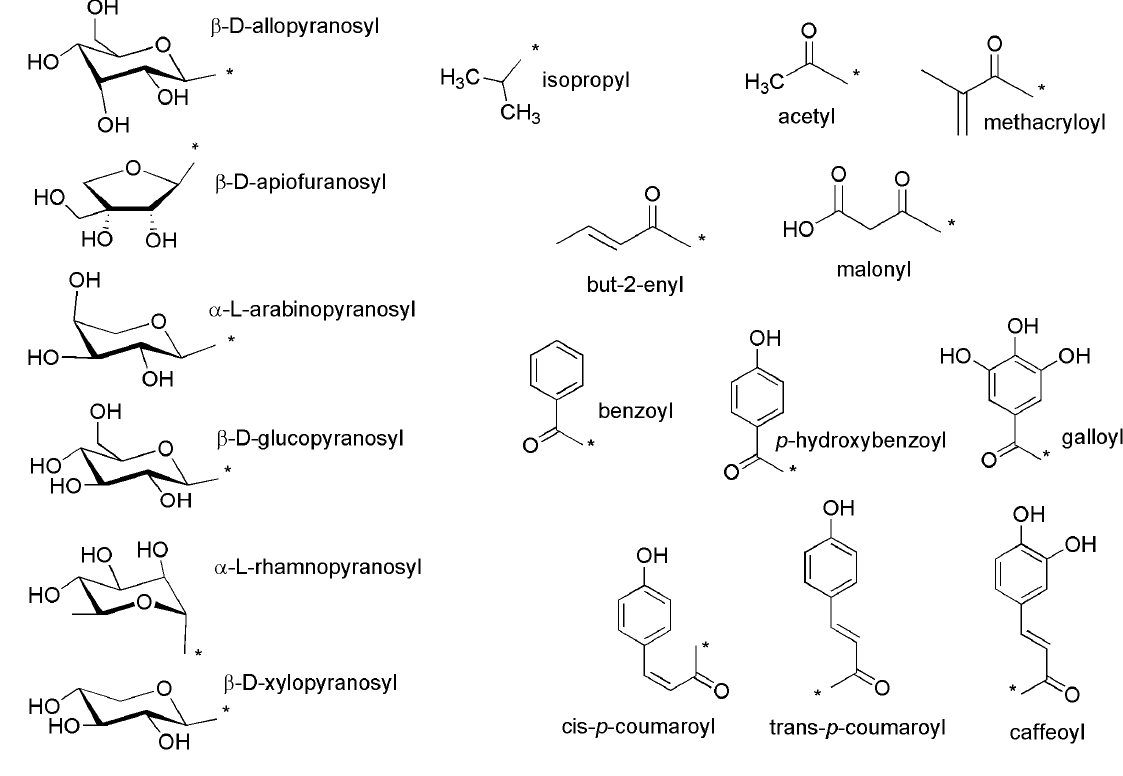
Figure 19. Substituents usually not fully drawn in Figures 2–18.